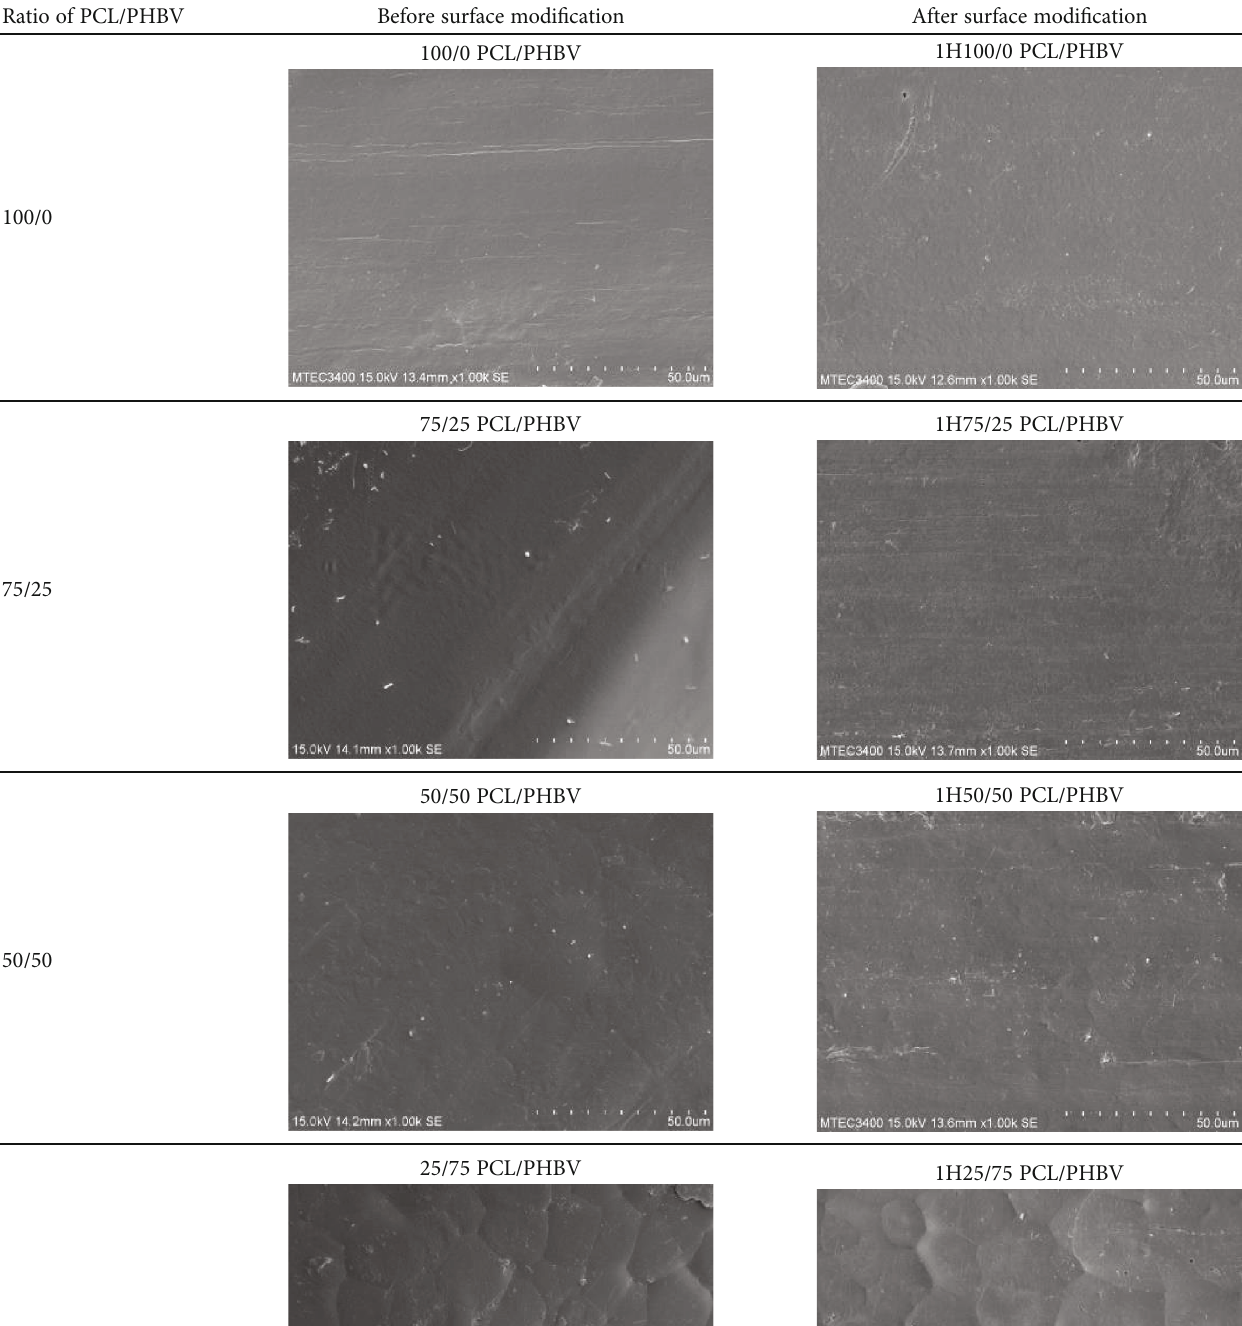
Table 2: SEM images of surfaces of PCL/PHBV sca ff olds with di ff erent ratios of blending before and after surface modi fi cation with